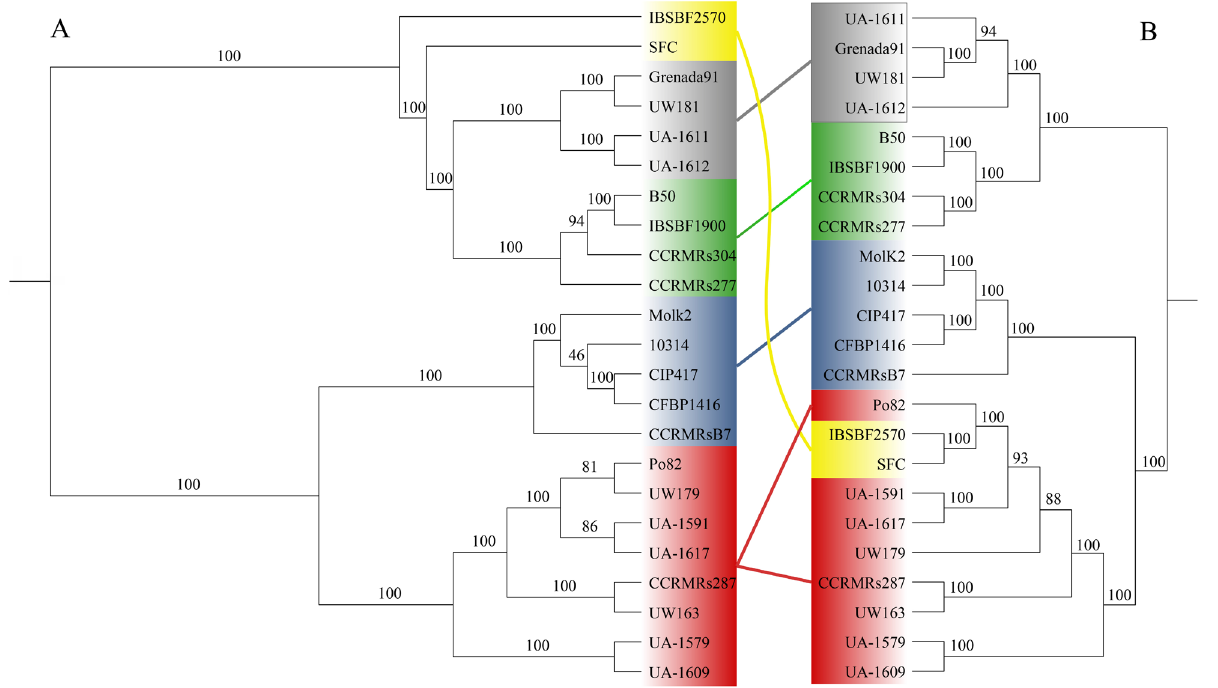
Figure 2 – (A) Maximum likelihood phylogenetic tree of core gene sequences annotated for the Ralstonia solanacearum Moko ecotype genomes and its symptomatological variants. (B) Maximum likelihood phylogenetic tree based on the presence or absence of orthologous genes of R. solanacearum Moko ecotype genomes and its symptomatological variants. * Subgroup IIA(α) is shown in green, IIA(β) in black, IIB(α) in blue, and IIB(β) in red. Strains of Sergipe facies (IBSBF2570 and SFC, IIA- β) are shown yellow. Strains of Moko ecotype causing Bugtok symptoms (CIP417 and Molk2), Sergipe facies (IBSBF2570 and SFC), and typical symptoms of Moko (all other strains) are